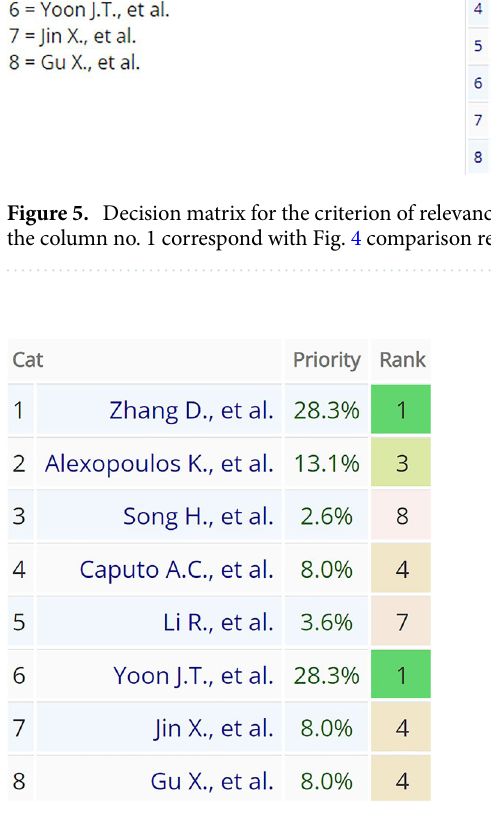
Figure 6. Consolidated priority scores under the criterion of relevance comparison (screenshot from AHP-OS software).